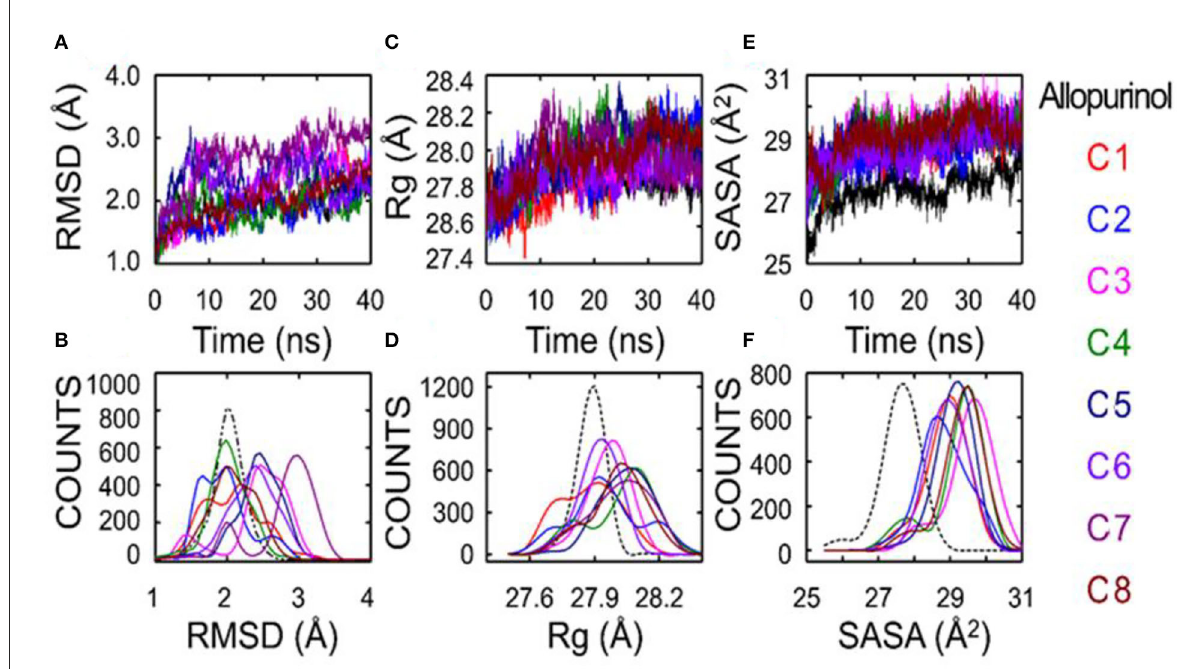
FIGURE5 Superposed plots for the RMSD, radius of gyration (Rg), and SASA of allopurinol–XO and phenolic compounds–XO. (A) Superposed RMSD graph, (B) The frequency distribution graph (RMSD vs. frequency counts), (C) Superposed Rg graph, (D) The frequency distribution graph (Rg vs. frequency counts), (E) Schematic representation of the solvent-accessible surface area (SASA), and (F) Distribution of SASA. SASA, solvent accessible surface area; RMSD, root-mean-square deviation; C1, quercetin; C2, quercetin-3-rhamnoside; C3, 4,5-O-dicaffeoylquinic acid; C4, 3,5-O-dicaffeoylquinic acid; C5, 3,4-O-di-caffeoylquinic acid; C6, 4-O-caffeoylquinic acid; C7, 3-O-caffeoylquinic acid; and C8, caffeic